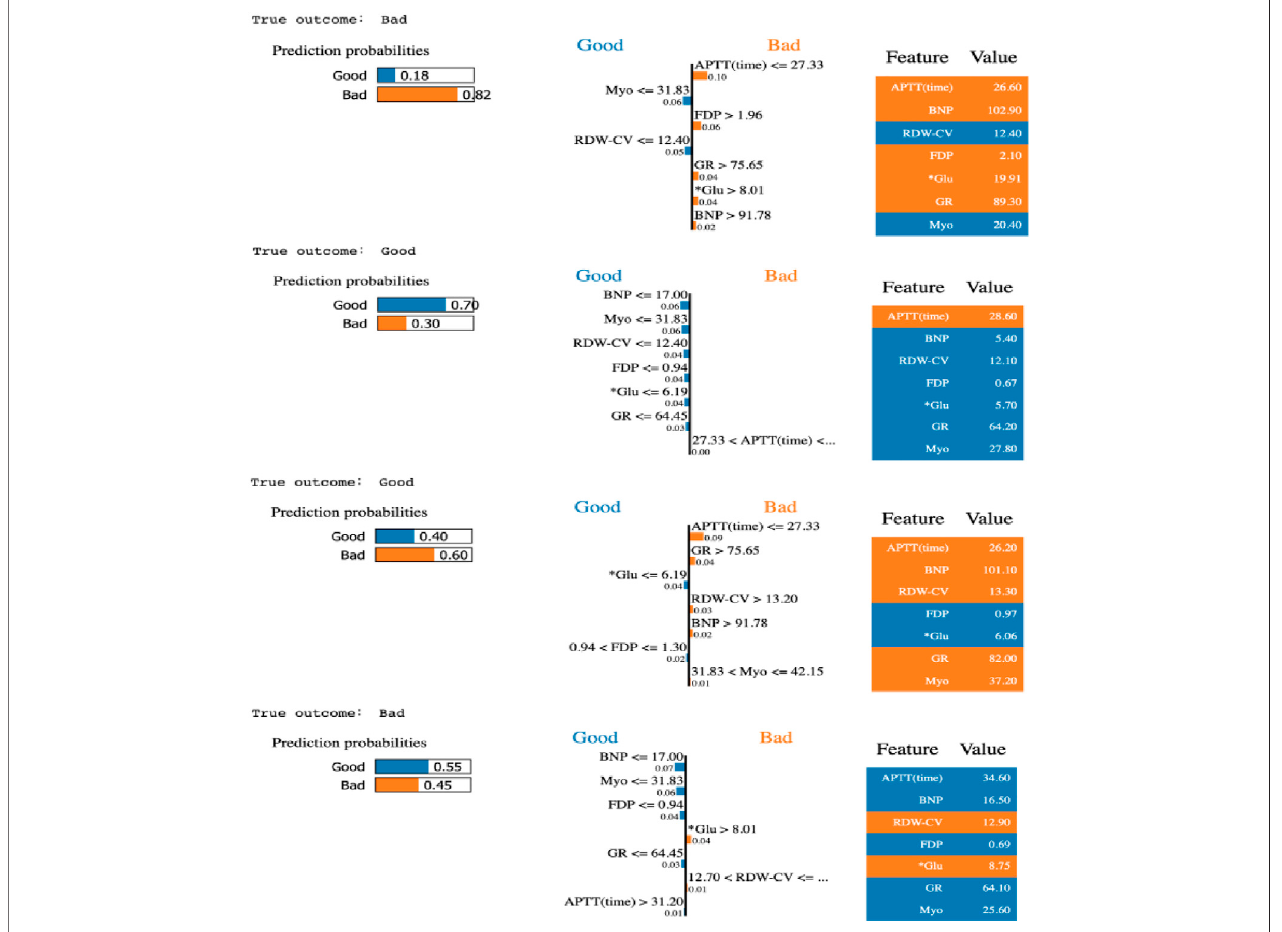
FIGURE 4 | Results of LIME with GBDT applied to four random selected